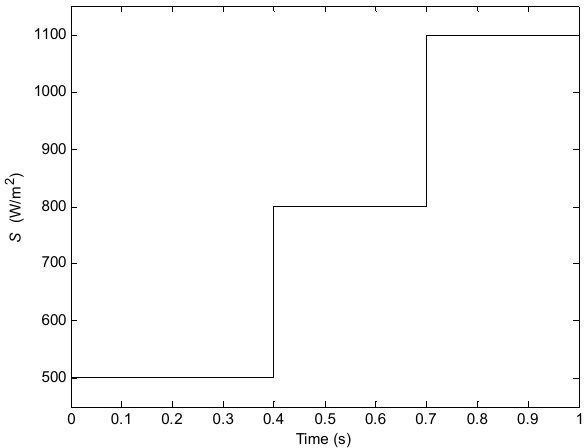
Figure 18. Assumed irradiance curve in second simulation.